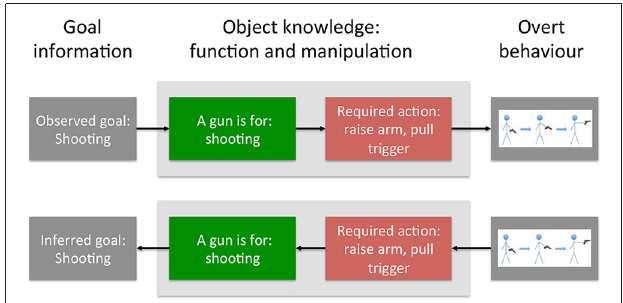
FIGURE 2 | Concrete example for the flow of information during action prediction and interpretation . Top panel: Action prediction. Prior knowledge of an actor’s goal (shooting) activates knowledge of objects with corresponding function. The associated manipulation knowledge (raising the arm, pulling the trigger) supports action prediction by biasing visual perception towards these manipulations. Lower panel: Action interpretation. Observed behavior is matched to the manipulations supported by the object. If both match, the corresponding functions are activated, providing likely goals of the